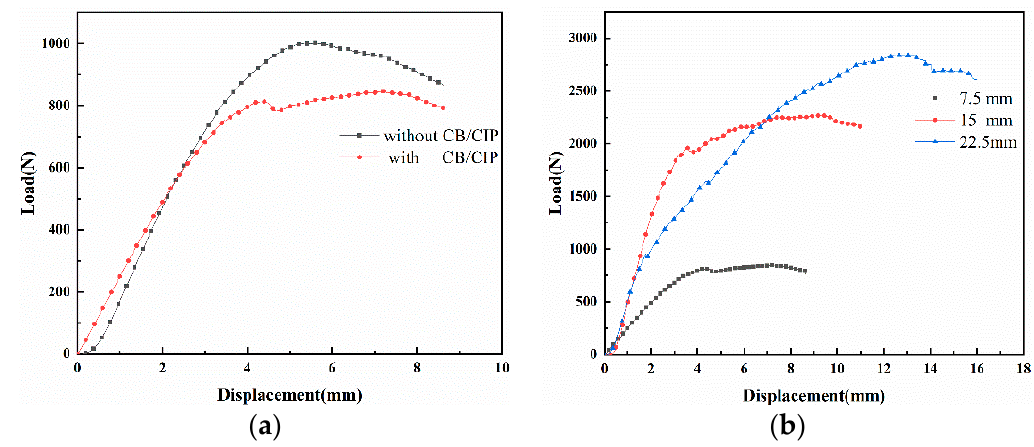
Figure 9. ( a ) Load–displacement curves of S0 and S1; ( b ) load–displacement curves of S1, S2 and